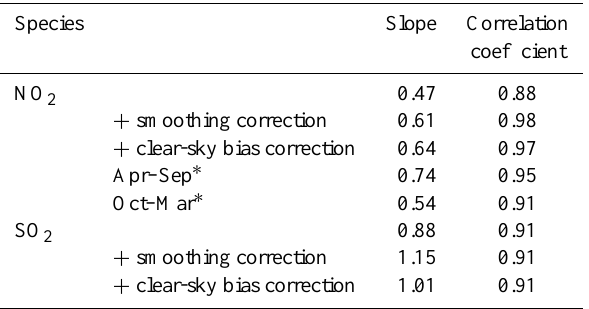
Table 4. Summary of comparisons between WBEA and OMI-EC- derived long-term (2005–2011) average volume mixing ratios. The slope and correlation coefficient are based on a sample of 12 SO 2 stations and 8 NO 2